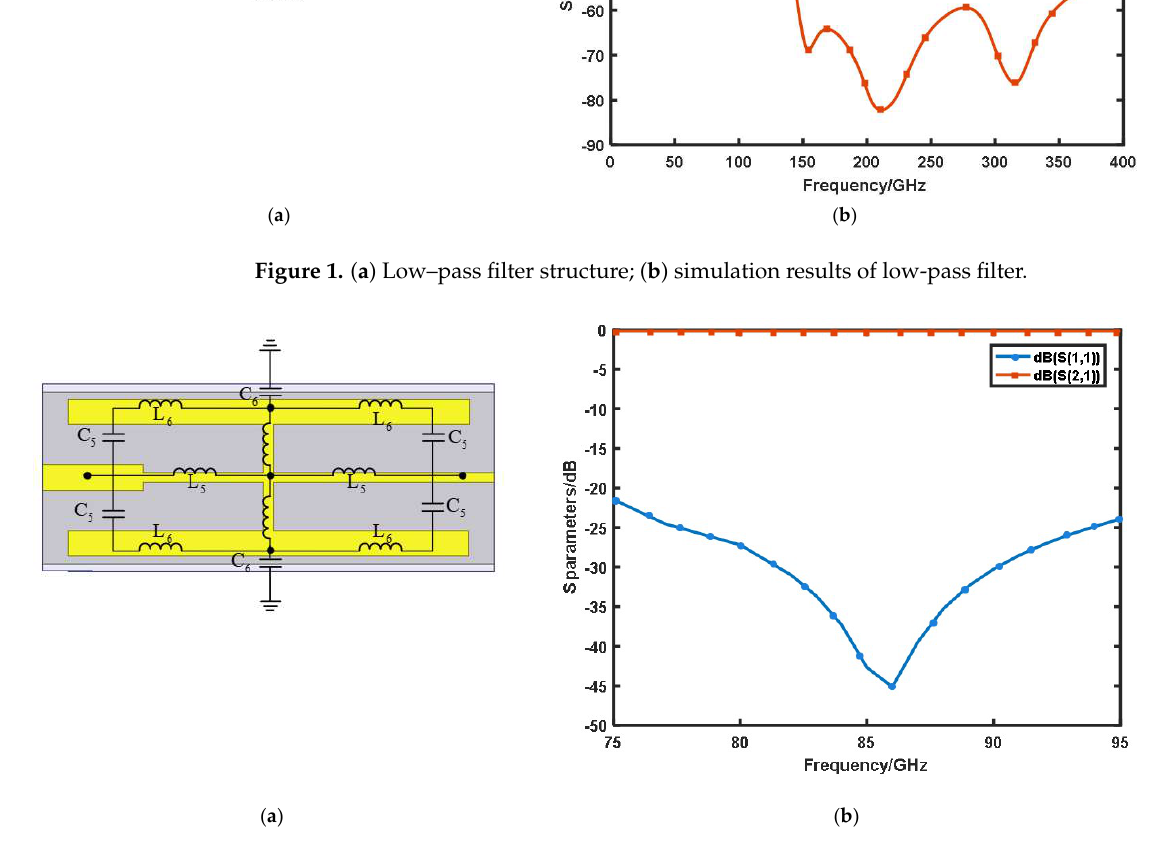
Figure 1. ( a ) Low–pass filter structure; ( b ) simulation results of low-pass filter.